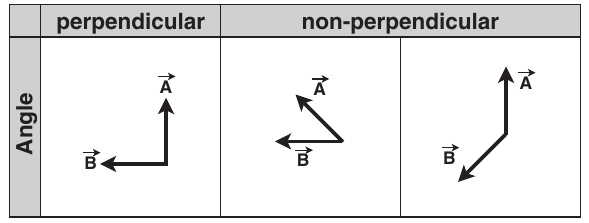
FIG. 6. Examples of one orientation, ðþ ˆ y Þ × ð − ˆ x Þ ¼ þ ˆ z , with the vectors presented as Perpendicular and Nonperpendicular (with both acute and obtuse angles).